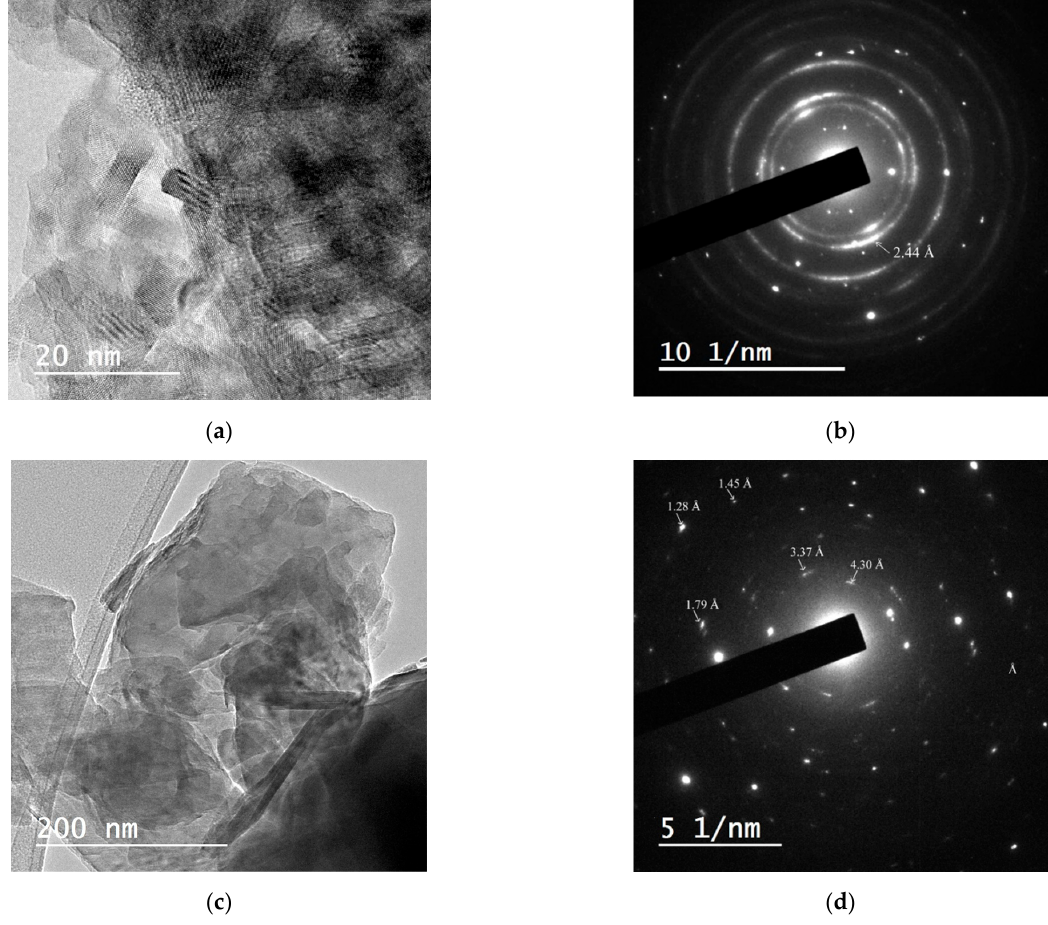
Figure 10. HRTEM micrographs of sample S2 showing their crystallinity with visible lattice fringes ( a ) and their layered structure ( c ) layered structure; ( b , d ) their corresponding SAED patterns showing a polycrystalline-like diffraction pattern with interplanar distances corresponding to moganite (JCPDS card no. 38–360).